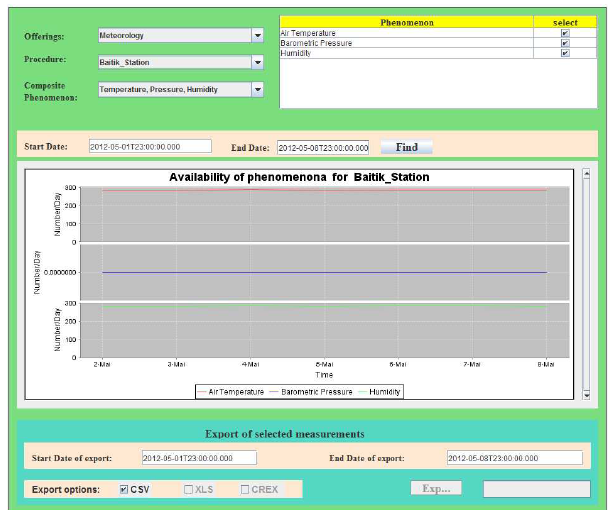
Fig. 6: Export of information from SOPAF. Graphical user interface (GUI) for users who prefer the data in the formats CSV (and in future also XLS or CREX).